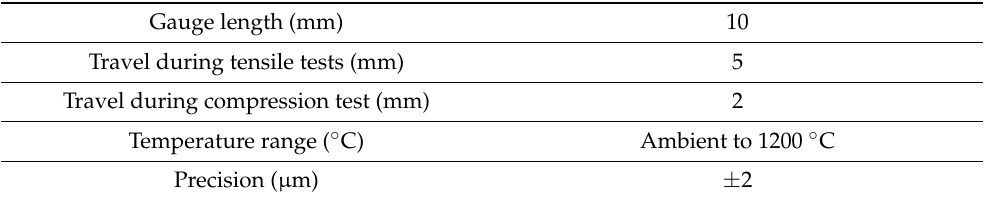
Table 2. Characteristics of HZT071